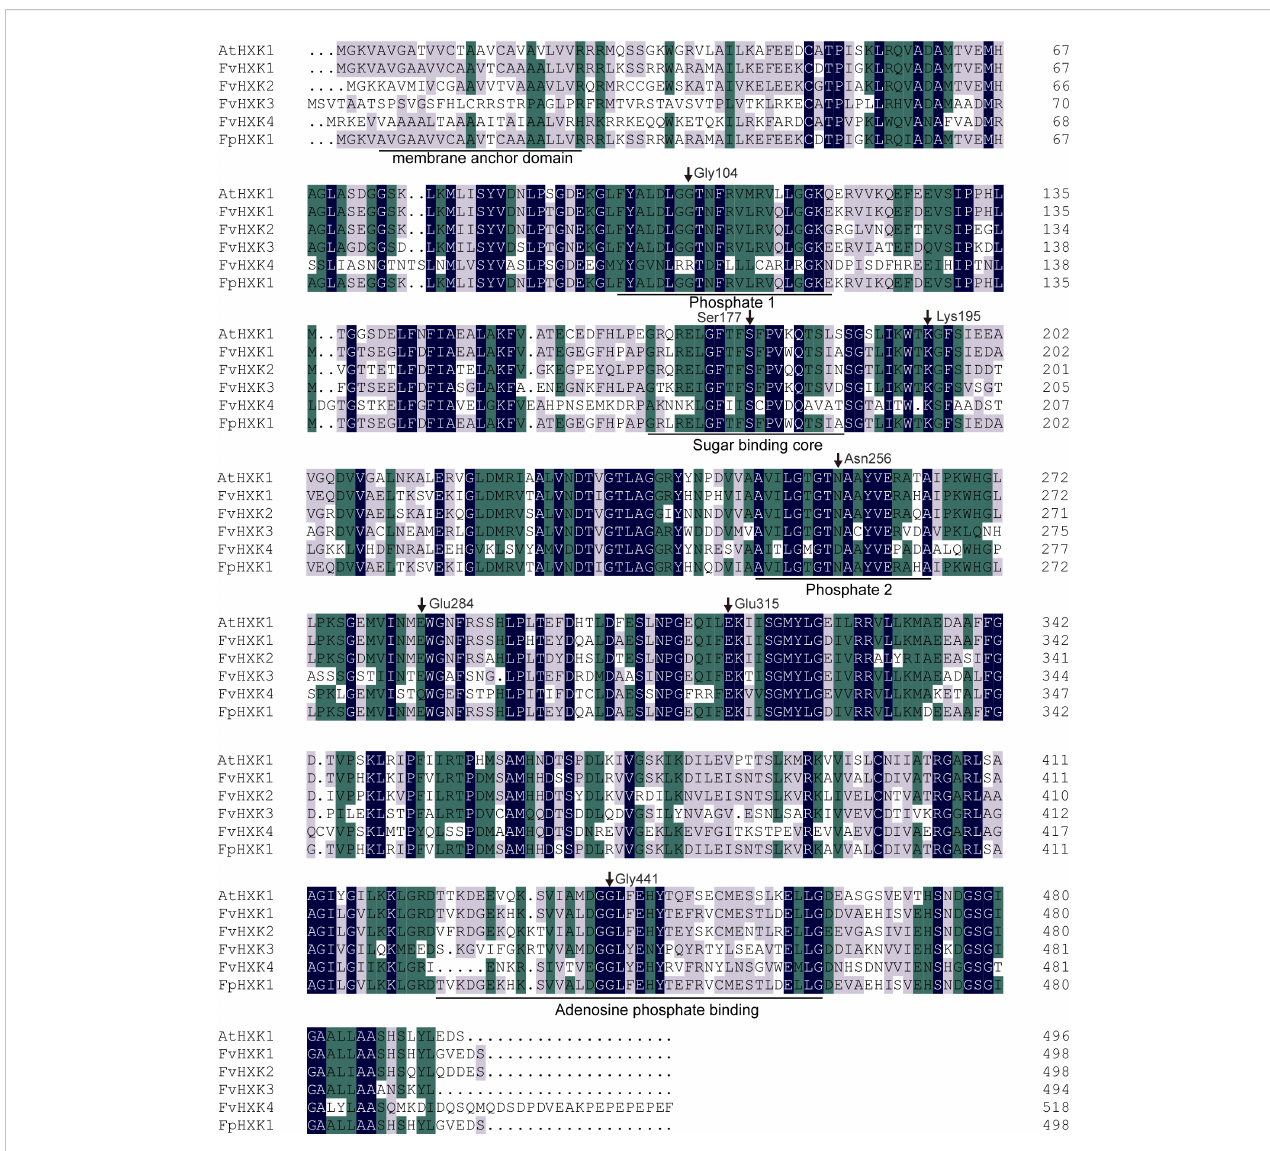
FIGURE 1 Amino acid alignment analysis of fi ve identi fi ed strawberry HXKs with AtHXK1. Regions with known functions were underlined. The black arrows represented conserved amino acids (counting based on AtHXK1), which are responsible for the catalytic activity and glucose and adenosine bonding referring to Karve et al. (2008). The shadings in black, green, and light purple re fl ect 100%, 75%, and 50% amino acid residue